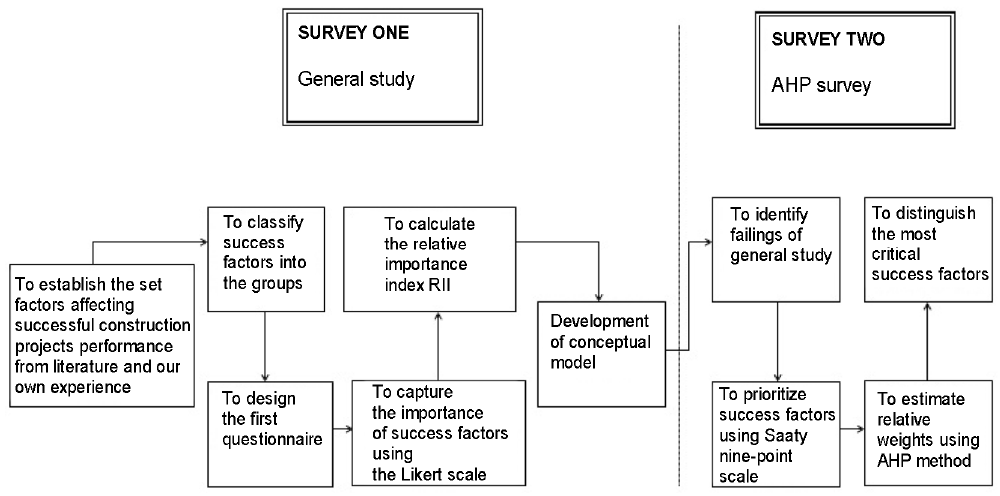
Fig. 1. The research